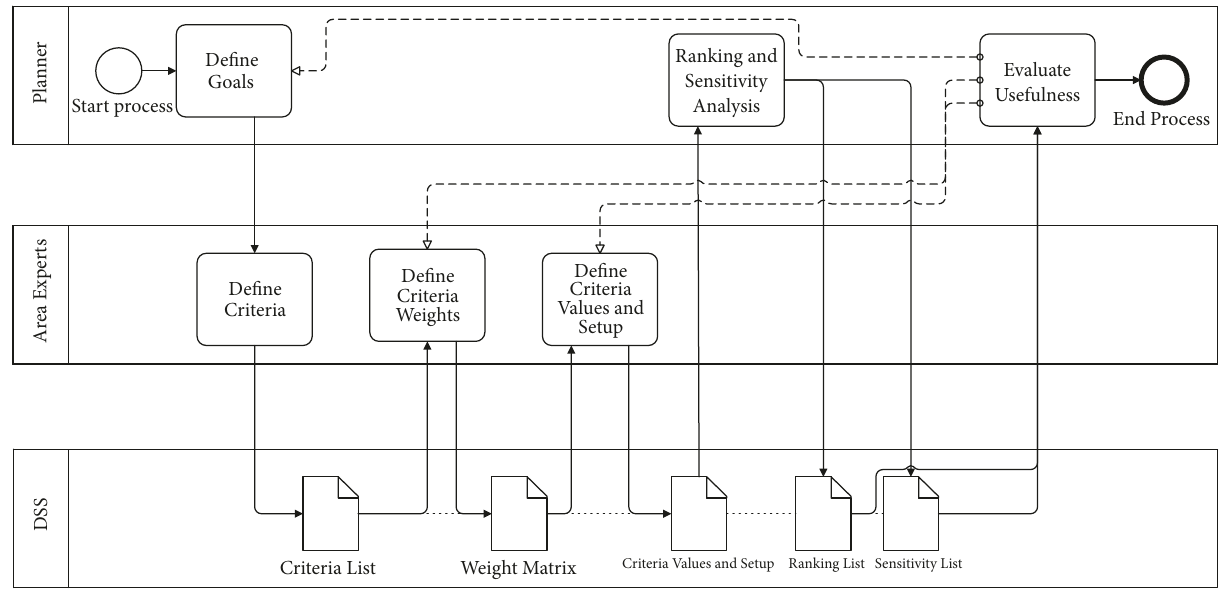
Figure 1: Knowledge management roles, activities, and process